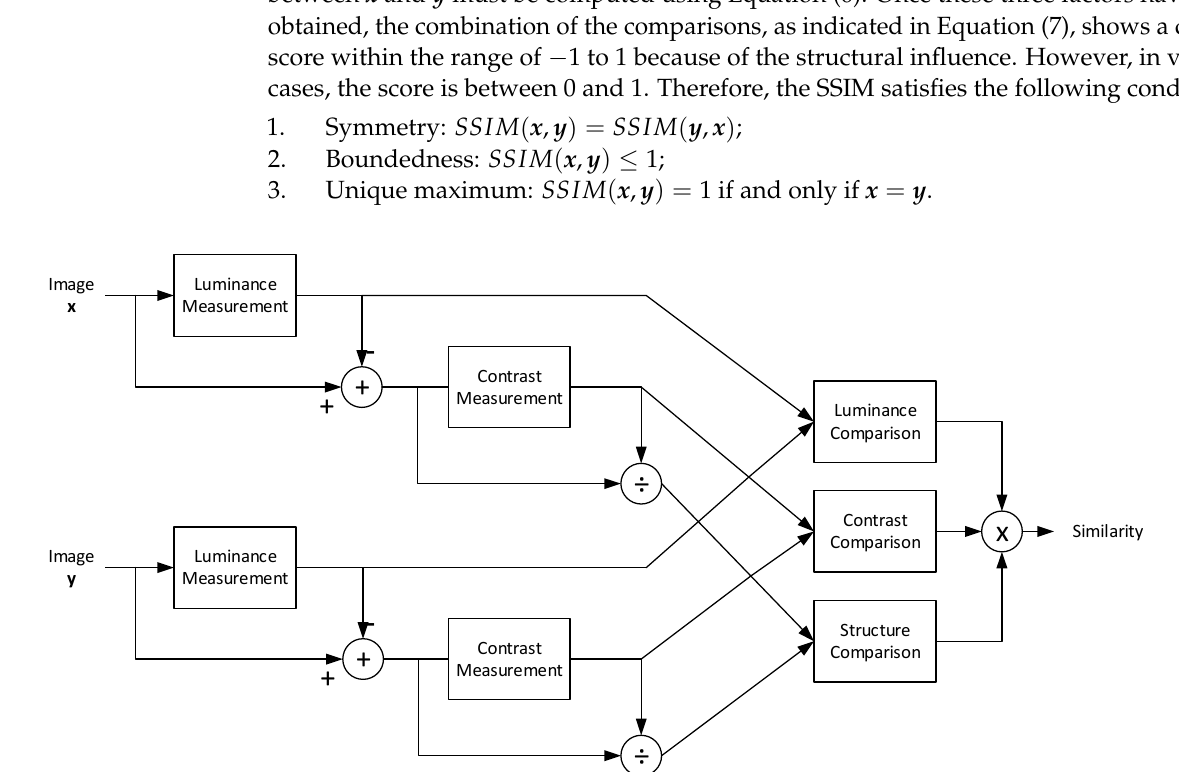
Figure 1. SSIM procedures to quantify the image quality (adapted from [10]).